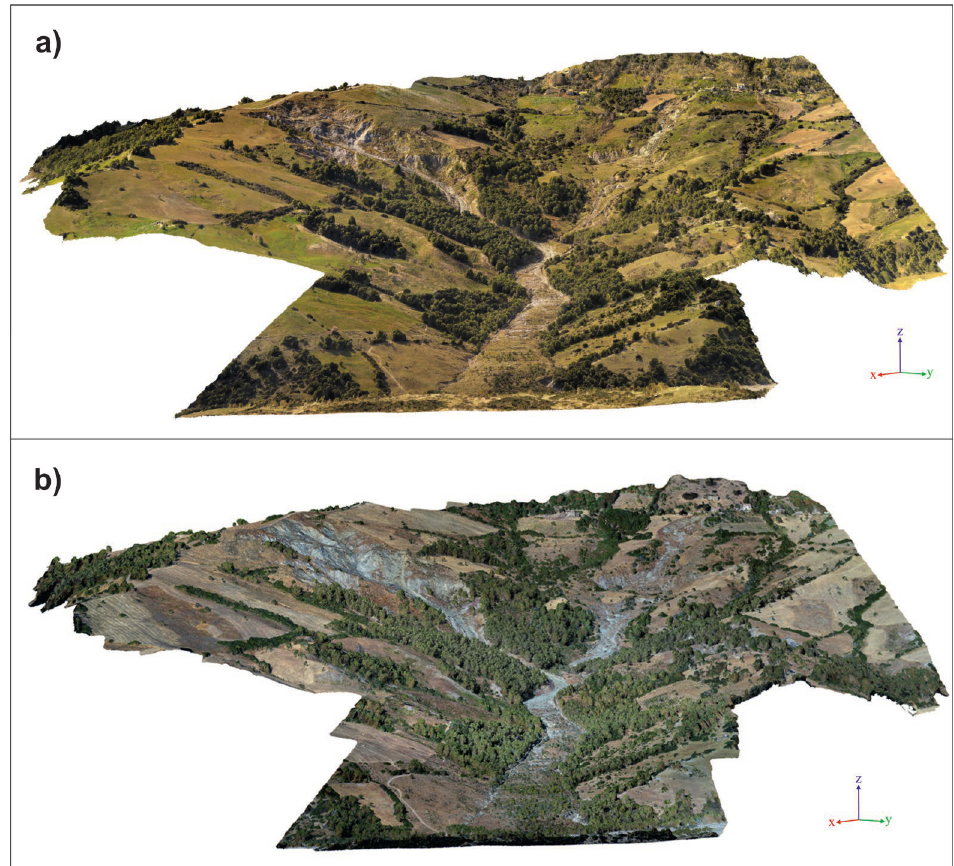
Figure 4. 3D model views (point cloud, texture, and mesh). ( a ) 2019 UAV survey; ( b ) 2022 UAV survey.